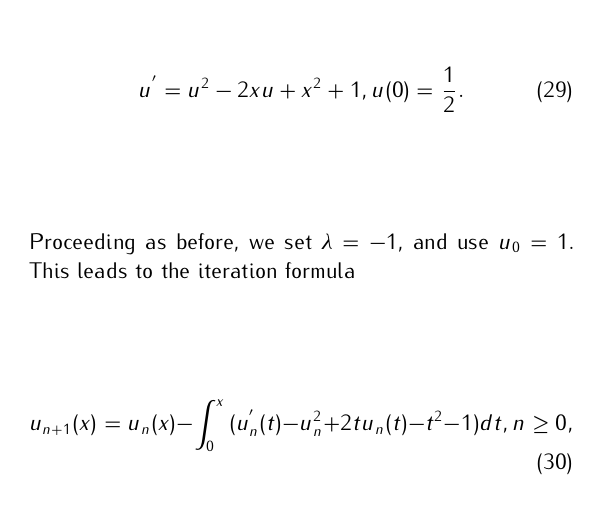
2 shows that the initial slope B = y the increase of α . Fig. 2 below shows the [3 / 3] Padé approximant of the approximation